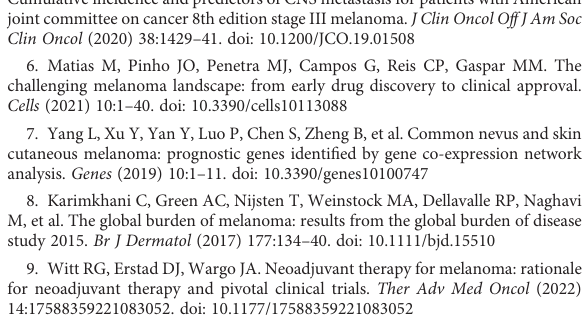
SUPPLEMENTARY FIGURE 5 Docking diagram of small molecular drugs with targets. (A) CD86- Baricitinib. (B) FCGR3A-Zofenopril calcium. (C) GZMB-Zofenopril calcium. (D) GZMB-AGI 6780. (E) STAT1-Gabaoentin. (F) TLR7- Gabaoentin. (G) STAT1-Calcipotriol. (H) TLR7-Zofenopril